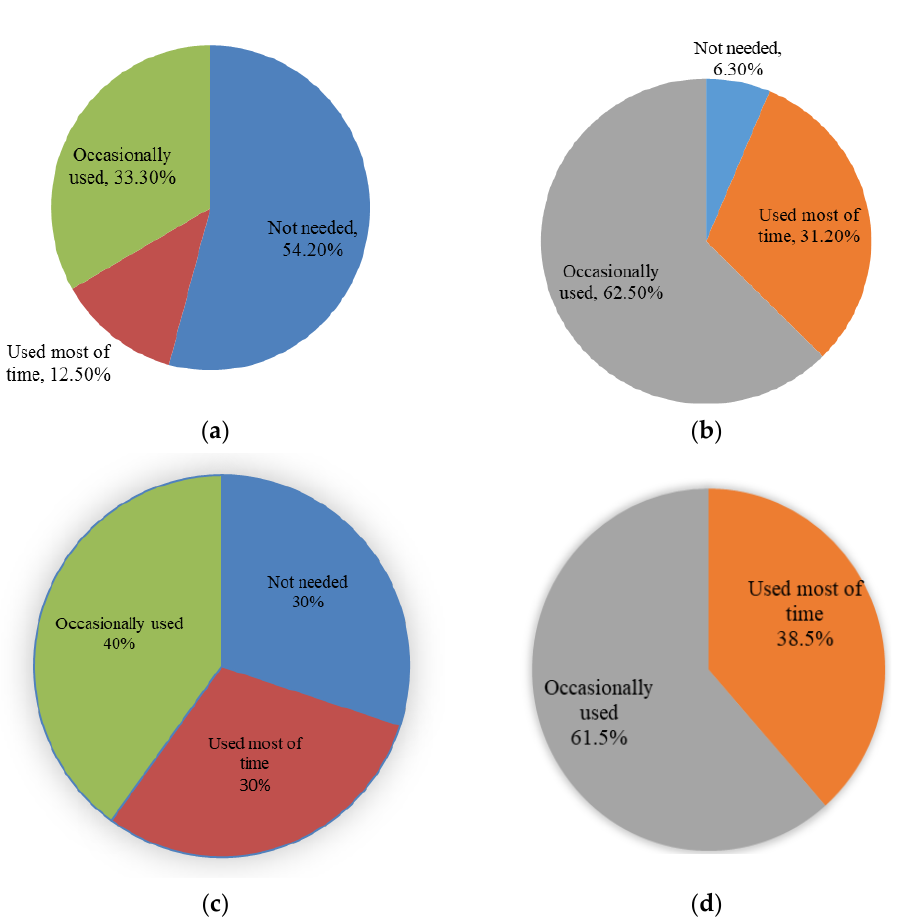
Figure 16. Handrail use during the experiments over the long stairway. ( a ) Male students; ( b ) female students; ( c ) middle-aged males; ( d ) middle-aged females.